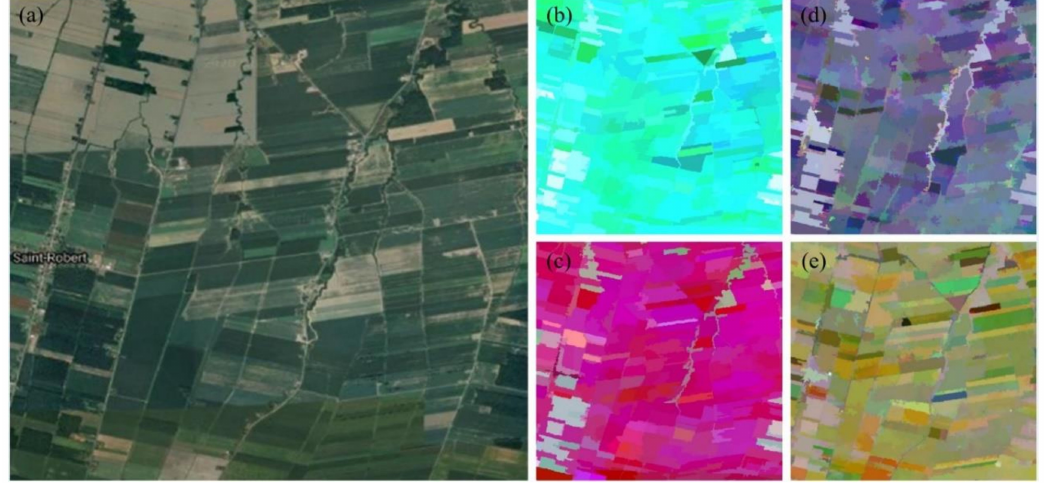
Figure 4. Results of applying the Simple Non-Iterative Clustering (SNIC) algorithm and the calculated mean value of each segment for a sample region in the study area. ( a ) high-resolution image of the corresponding region. False RGB color composites of ( b ) NDVI-1, NDVI-2, and NDVI-3, ( c ) NDWI-1, NDWI-2, and NDWI-3, ( d ) VV-1, VV-2, and VV-3, and ( e ) VV-4, VV-5, and VV-6 (NDVI: Normalized Di ff erence Vegetation Index, NDWI: Normalized Di ff erence Water Index, VV: Vertical transmit and Vertical receive